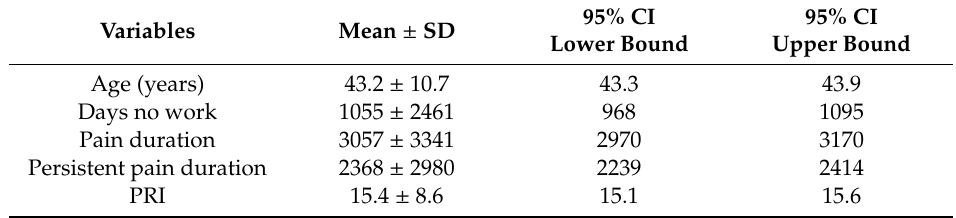
Table 1. Continuous background variables; mean ± SD and 95% confidence intervals (95% CI).